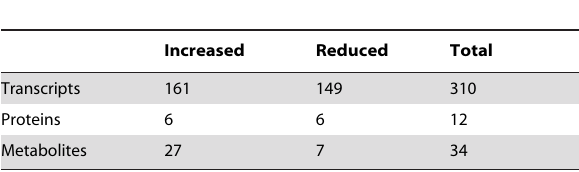
Table 2. Numbers of genes, proteins and metabolites of P. aeruginosa PAO1 differently expressed in biofilms grown on AUM compared to 10-fold diluted LB grown